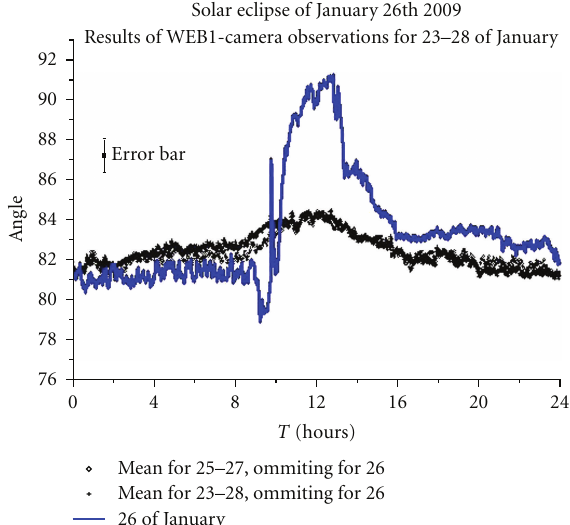
Figure 2: WEB-1 observations: the averaged daily variation (in black and grey) and the variation on January 26th, 2009, the day of the solar eclipse (in blue). T is local (Kiev) time.